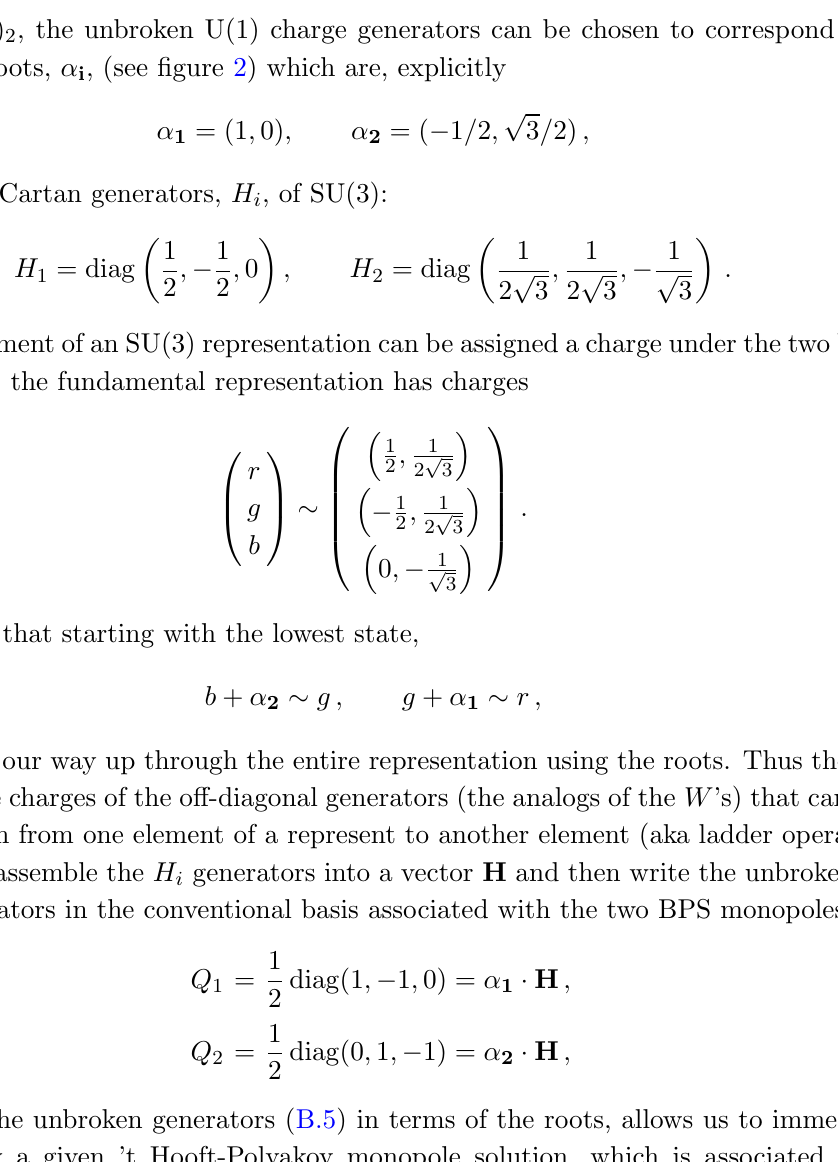
Figure 2 . Simple roots, (cid:11) 1 and (cid:11) 2 , of SU(3), and the lowest negative root (cid:11) 0